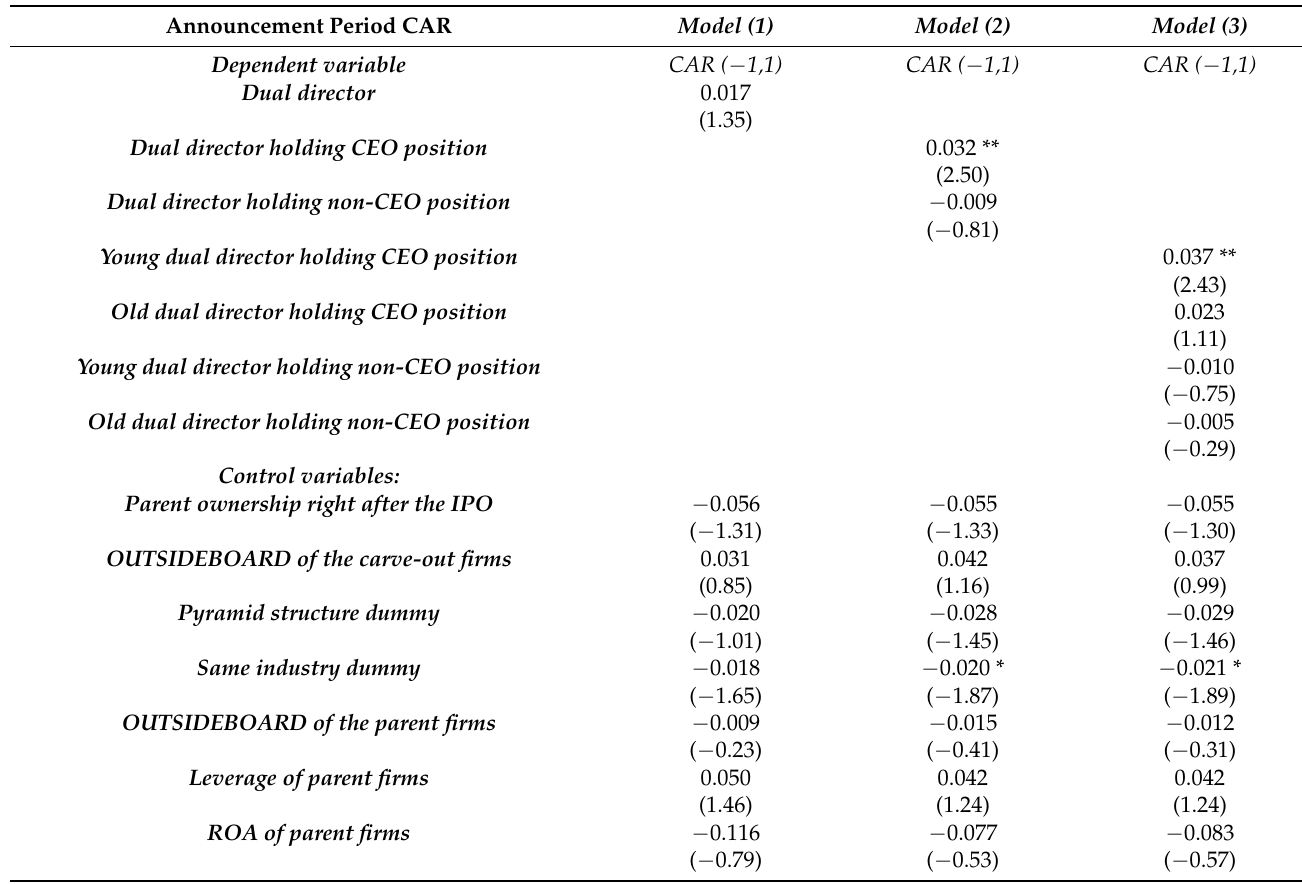
Table 5. Cross-sectional regressions of announcement period CAR. The dependent variable in all regressions is the three-day CAR surrounding the announcement day of the equity carve-out. Dual director takes a value of 1 for firms with at least 1 dual director and 0 otherwise. Dual director holding CEO position takes a value of 1 for firms with at least 1 dual director holding CEO position in the subsidiary firm and 0 otherwise. The dual director holding non-CEO position takes a value of 1 for firms with at least 1 dual director holding non-CEO position in the subsidiary firm and 0 otherwise. Young dual director holding CEO position takes a value of 1 for firms with at least 1 young dual director holding CEO position in the subsidiary firm and 0 otherwise. Old dual director holding CEO position takes a value of 1 for firms with at least 1 dual director holding CEO position (none of the CEO-dual directors are young) in the subsidiary firm, and 0 otherwise. Young dual director holding non-CEO position takes a value of 1 for firms with at least 1 young dual director holding non-CEO position in the subsidiary firm and 0 otherwise. Old dual director holding non-CEO position takes a value of 1 for firms with at least 1 dual director holding non-CEO position (none of the non-CEO-dual directors are young) in the subsidiary firm, and 0 otherwise. Parent ownership right after the IPO is the percentage of shares owned by parent firms right after equity carve-out. OUTSIDEBOARD is the number of outside board members divided by board size. The pyramid structure dummy takes a value of 1 if the parent firms indirectly control the carve-outs and 0 otherwise. Same industry dummy takes a value of 1 if a subsidiary and its parent are in the same industry and 0 otherwise. Parent proceeds is secondary proceeds sold by parent firms divided by their total assets before carve-out. Subsidiary proceeds are primary proceeds raised by a subsidiary firm divided by total assets before carve-out. Leverage is total liabilities scaled by total assets. ROA is operating income divided by total assets. Relative size is the subsidiary’s total assets divided by the parent’s total assets before carve-outs. The t-statistics are in parentheses. *, **, and indicate significance at the 10% and 5% levels,